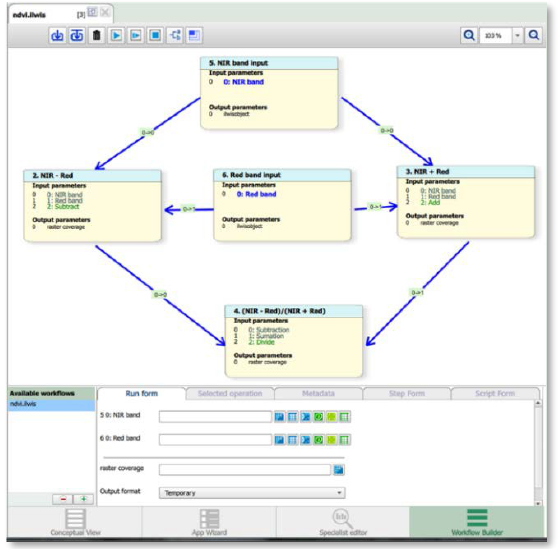
Figure 2. Workflow builder in ILWIS. Depicted is the workflow for the calculation of a Normalized Difference Vegetation Index